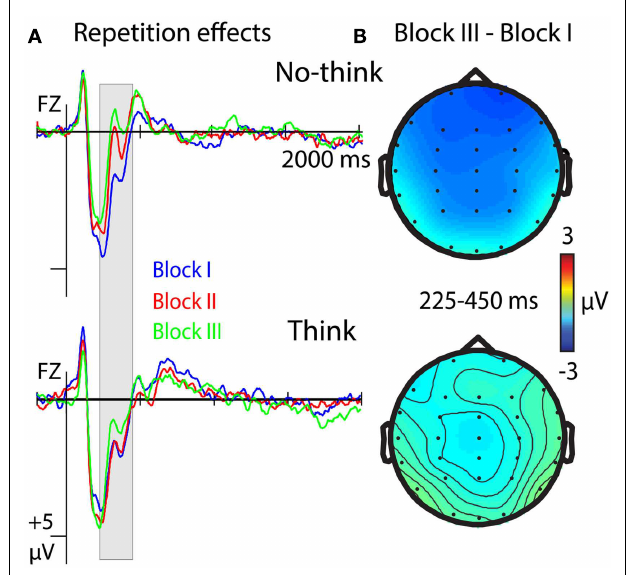
FIGURE 5 | ERP correlates of a reduction of memory strength with repeated suppression attempts for no-think items (top row) and think items (bottom row). (A) ERPs at electrode Fz from the three parts (block I, II, III) of the think/no-think phase. Negative polarity is plotted upwards. (B) Topographical difference between ERPs from the first (block-I) and the last part (block-III) of the think/no-think